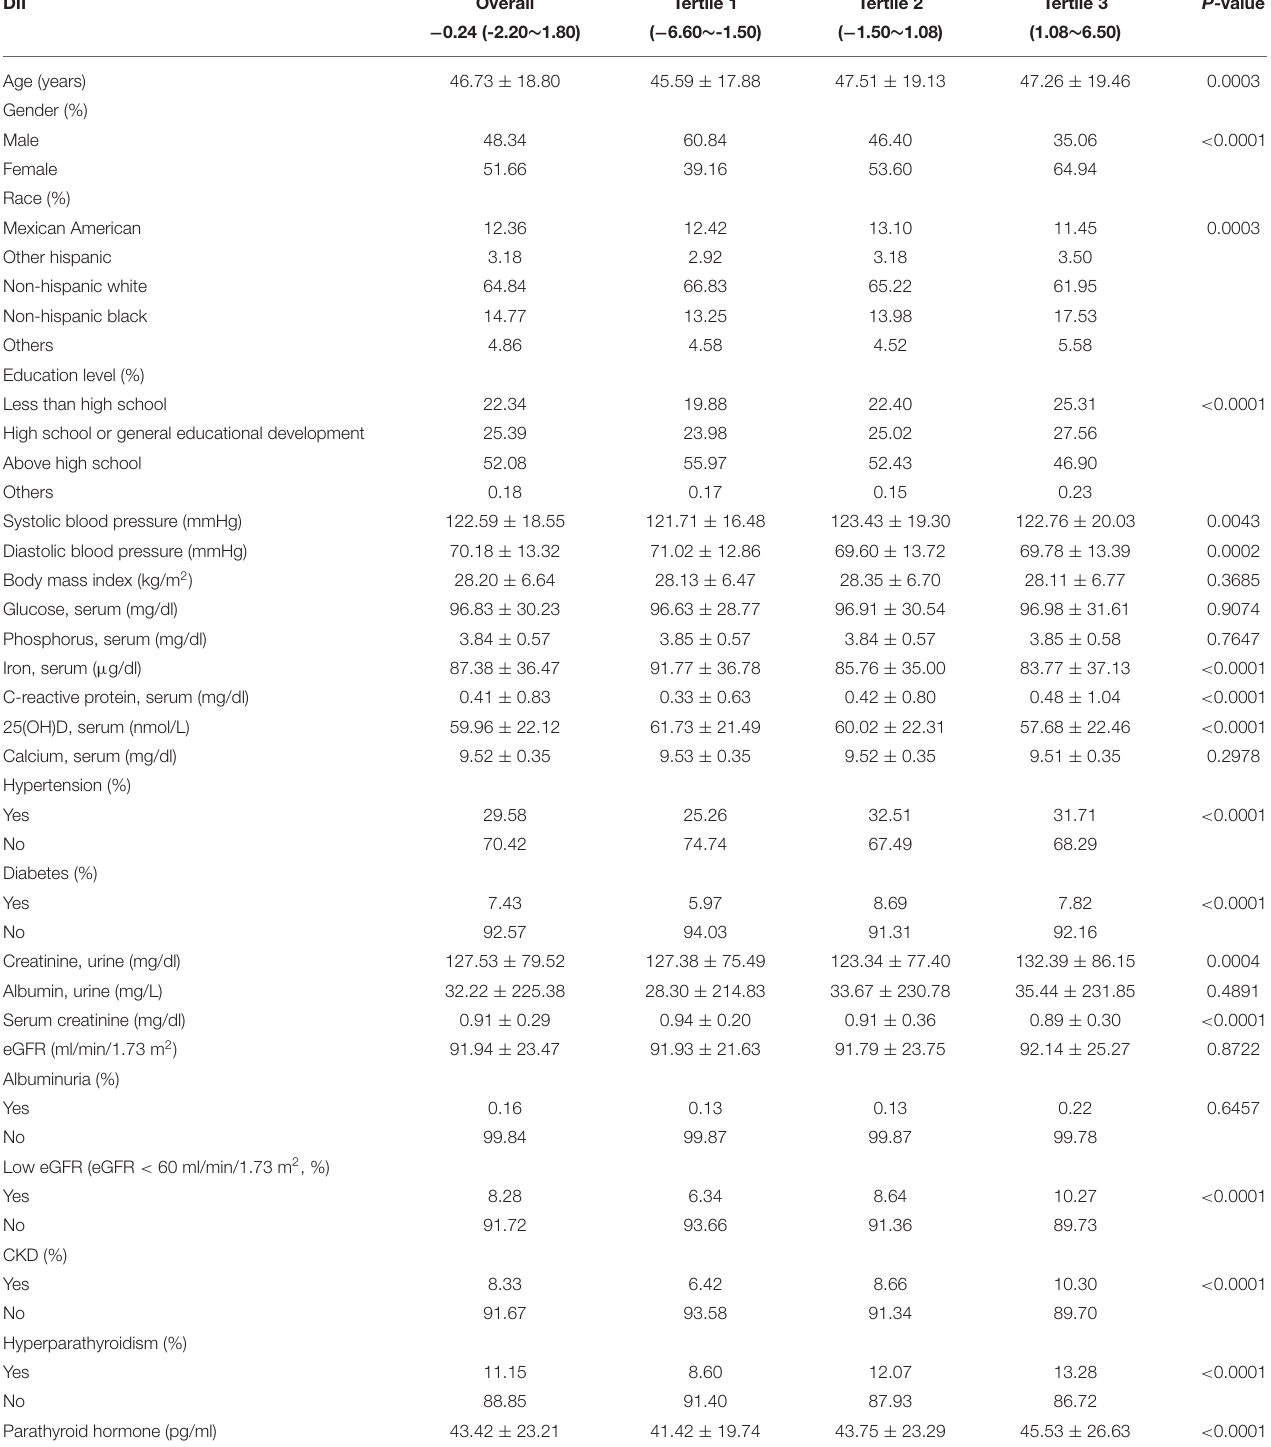
TABLE 1 | Weighted baseline characteristics of the participants according to different dietary inflammatory indexes (DIIs). DII Overall Tertile 1 Tertile 2 Tertile